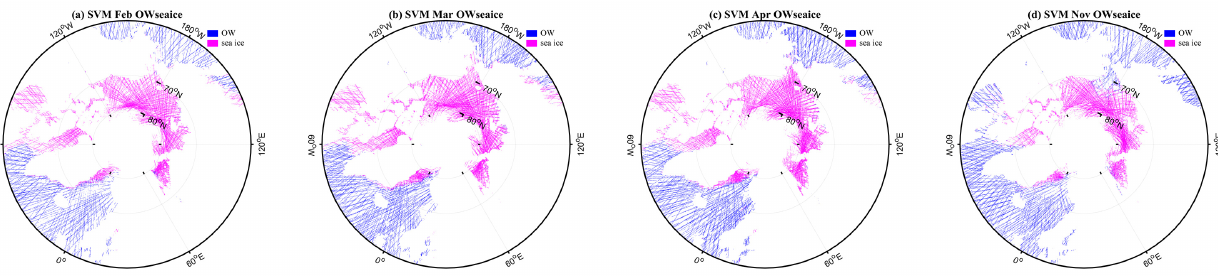
Figure A11. RF for FYI-MYI classification using the data in February as the training set. The data in ( a ) March, ( b ) April, ( c ) November, and ( d ) December are used as the test set in turn.